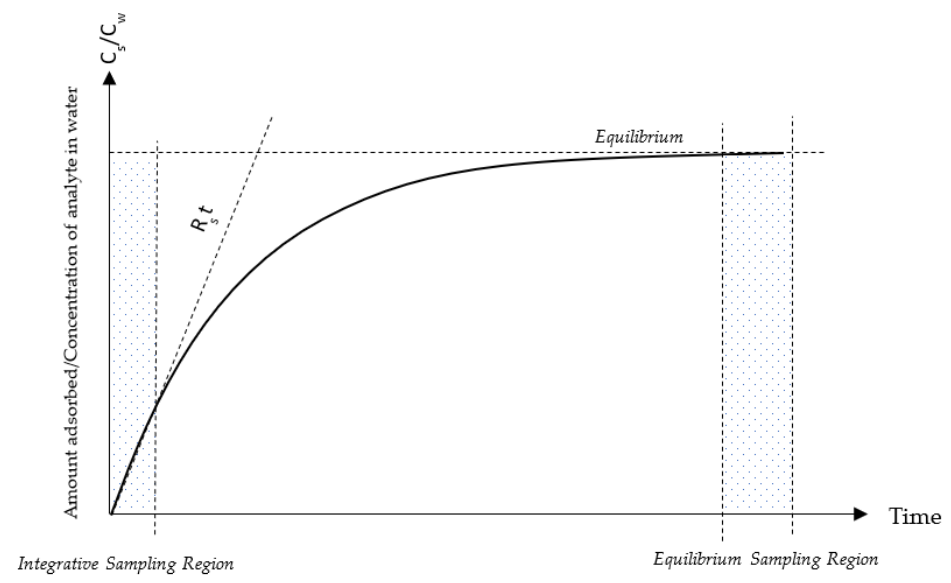
Figure 1. General form of analyte uptake in passive samplers [11].